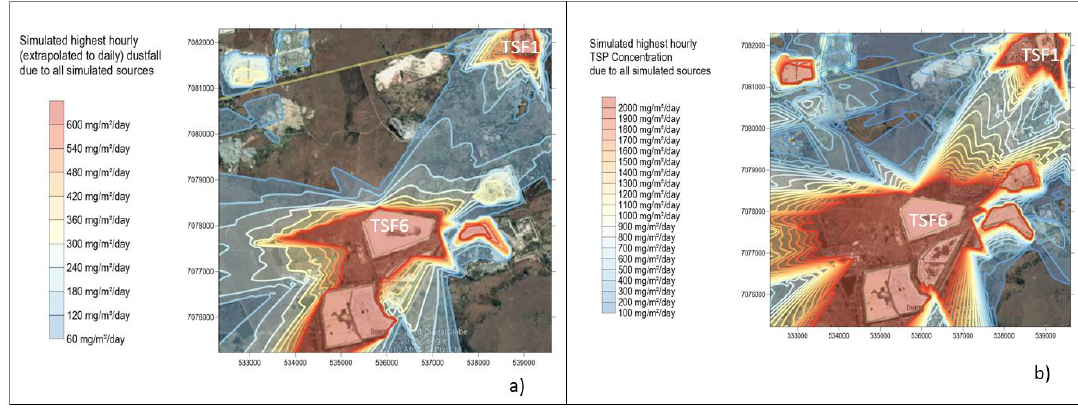
Figure 8. ( a ) Simulated highest hourly Dustfall and ( b ) TSP due to all simulated sources.